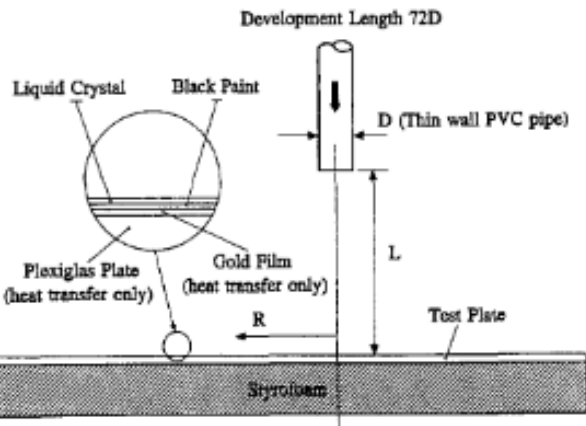
Figure 2. Liquid crystal-based experimental setup [5]. Reprinted with permission: License number 5177100108751.